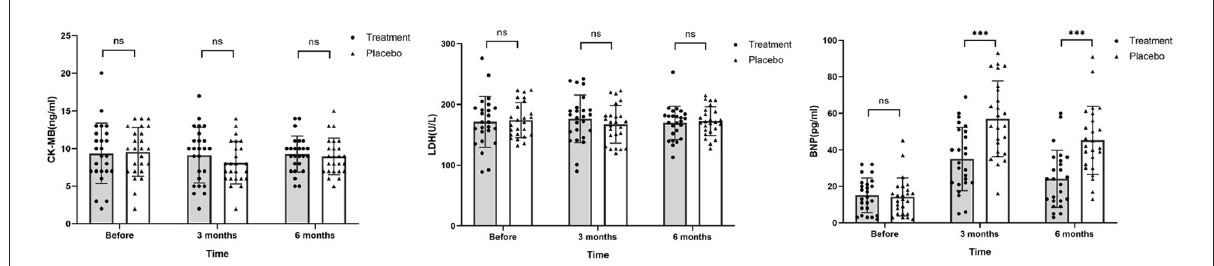
FIGURE5 Levels of CK-MB, LDH, and BNP before chemotherapy, 3 and 6 months after chemotherapy. Before and after chemotherapy, the values of CK-MB and LDH in both groups decreased to a certain extent, but the difference was not statistically significant. BNP values in the placebo group were significantly higher than that in the treatment group after chemotherapy (ns, not significant; *** P ≤ 0.001).